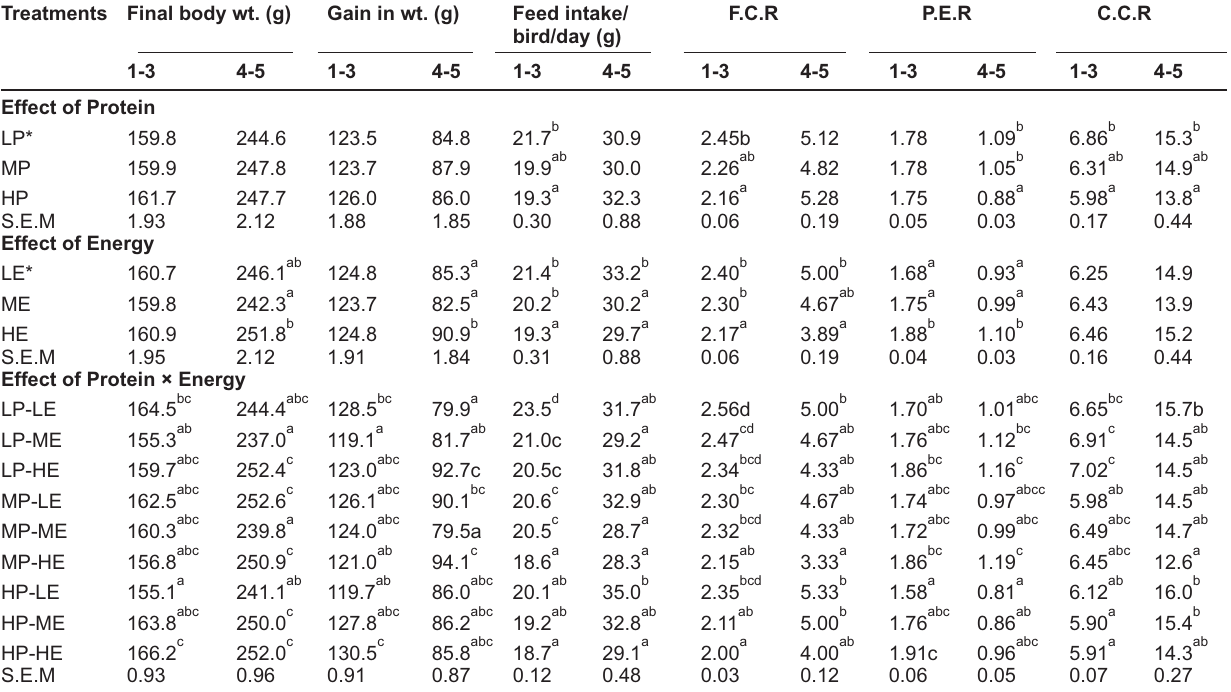
Table-2: Growth performance at different levels of protein and energy during starter and finisher phase. Treatments Final body wt. (g) Gain in wt. (g)